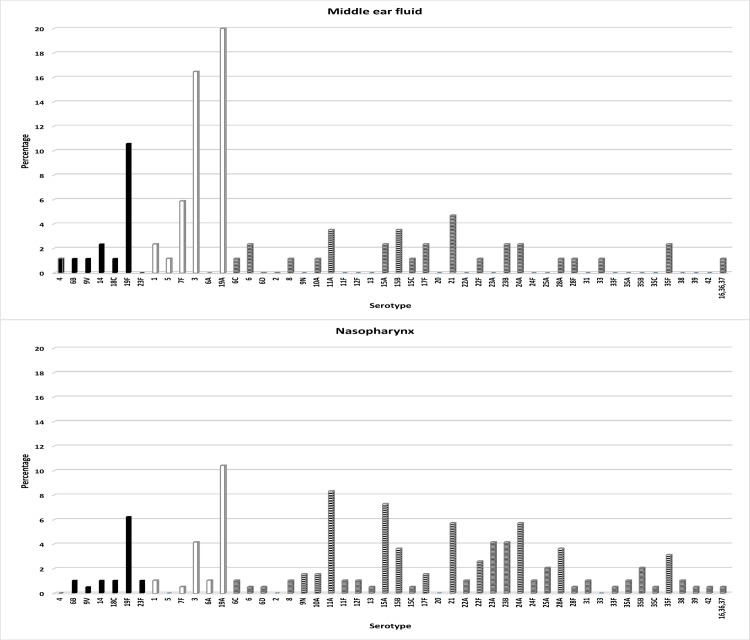
Serotypes identified in middle ear fluid and in nasopharynx among typed pneumococci (PCV7 serotypes: black columns; 6 newly added serotypes in PCV13: white columns; non-PCV13 serotypes: striped columns).